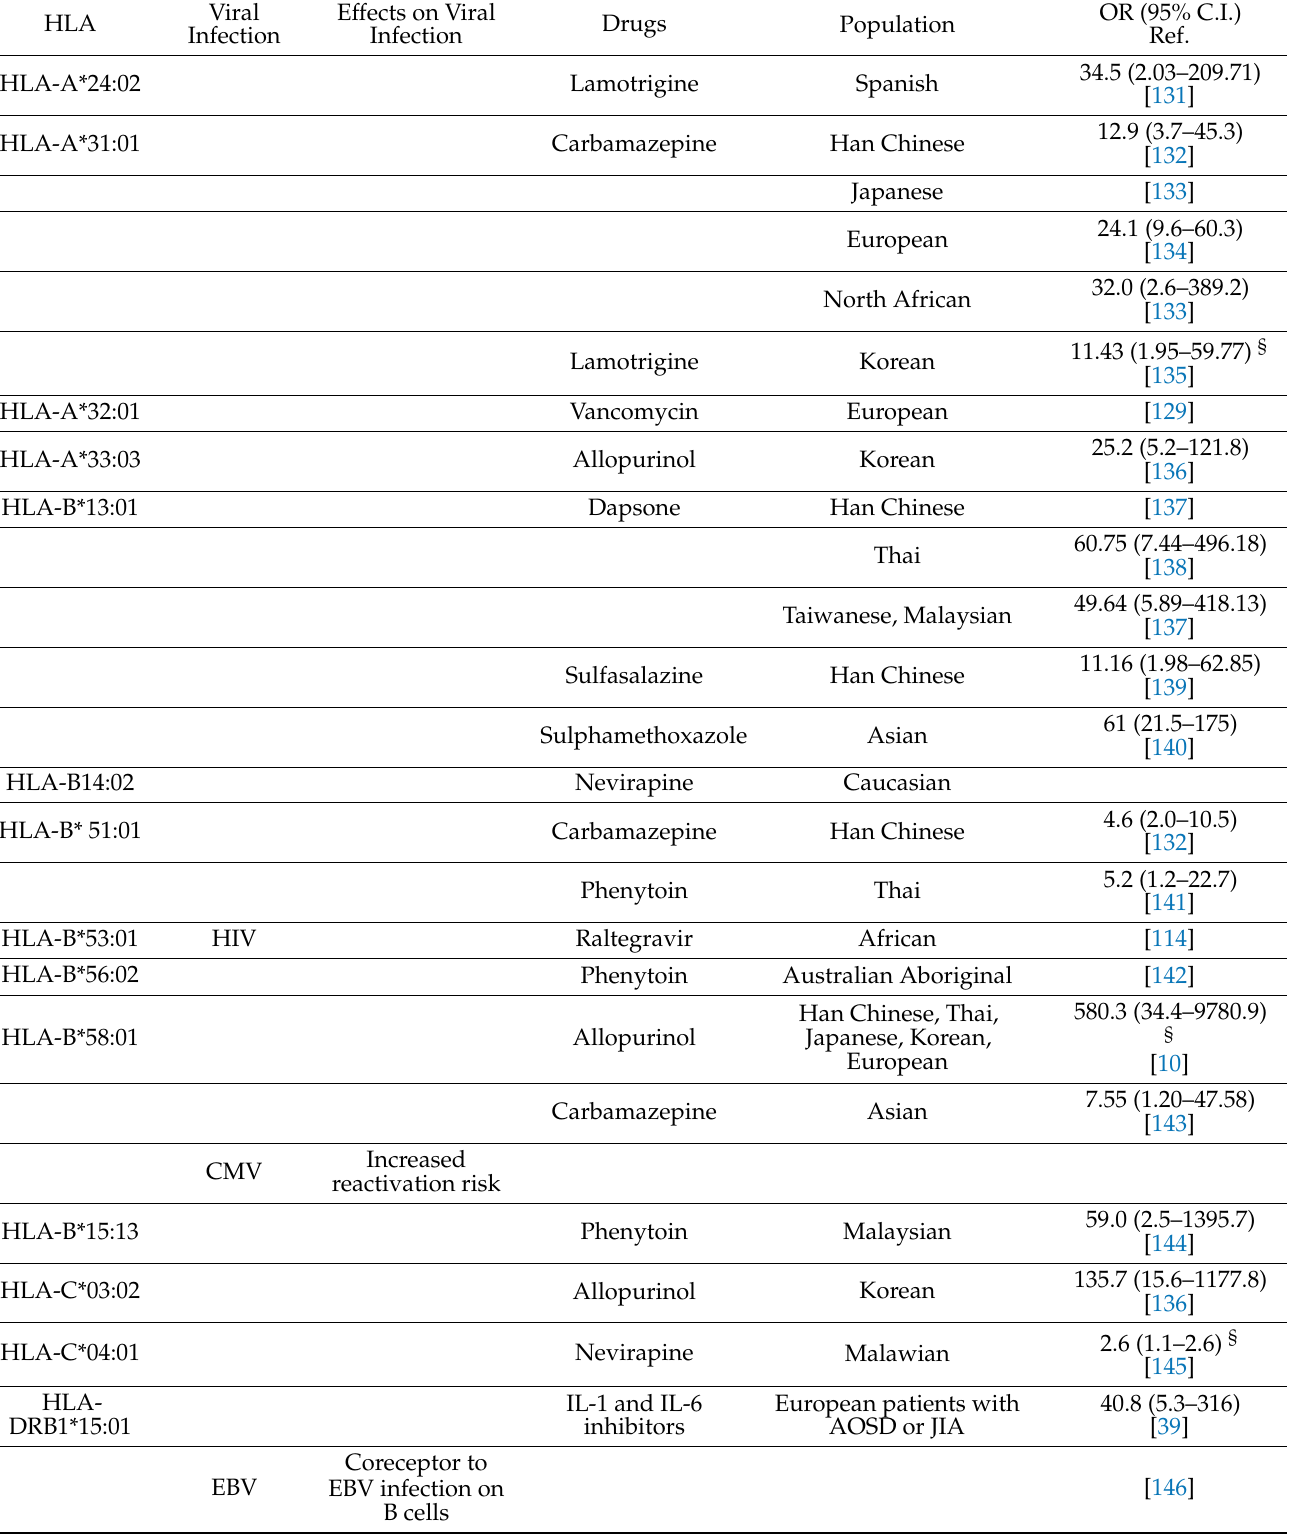
Table 2. Selected HLA haplotypes associated with